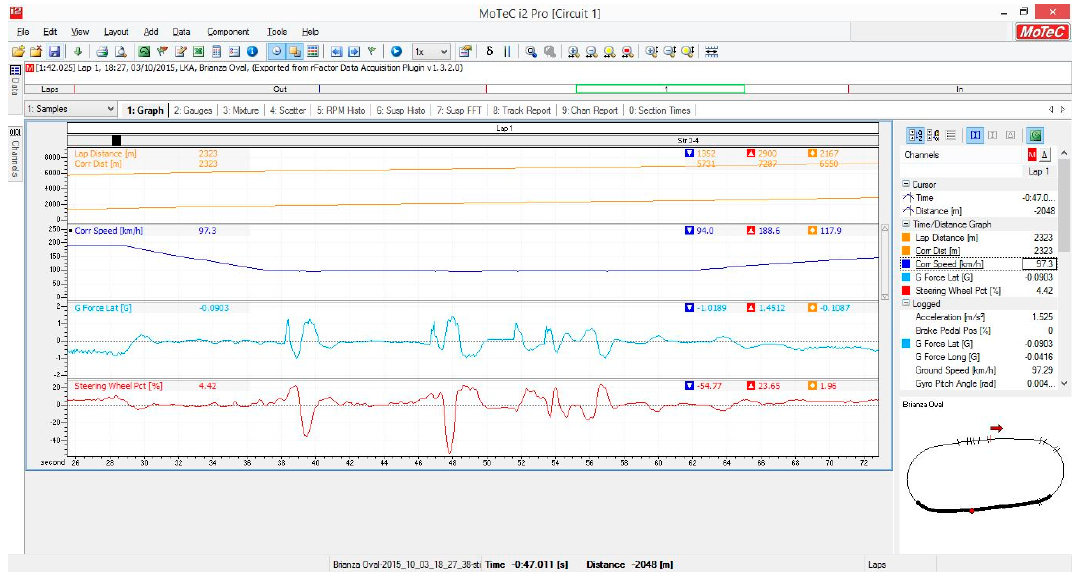
Figure 4. Telemetry panel with indication of the steering angle.